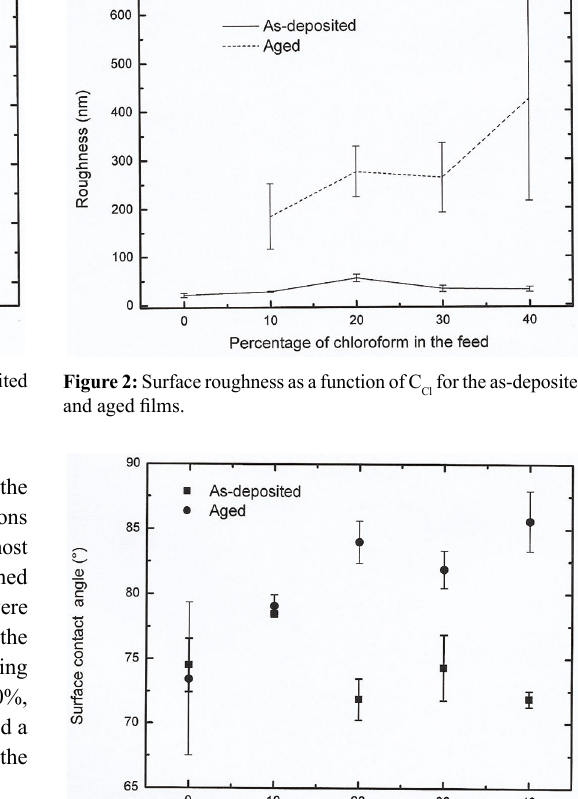
Figure 3: Surface contact angle as a function of C deposited and aged